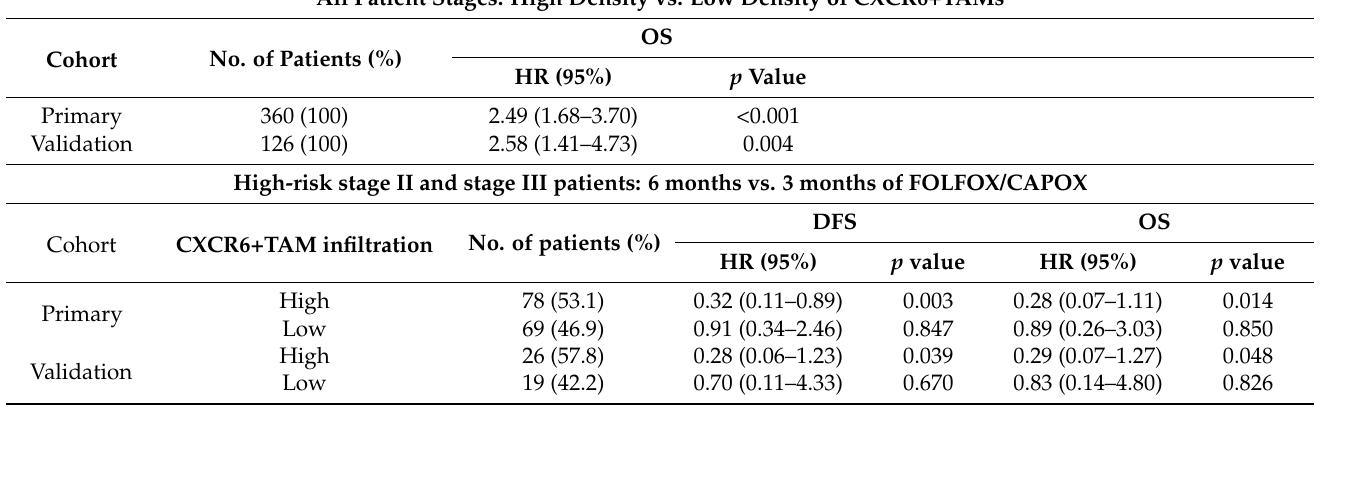
Table 3. Results of CXCR6+TAMs as a